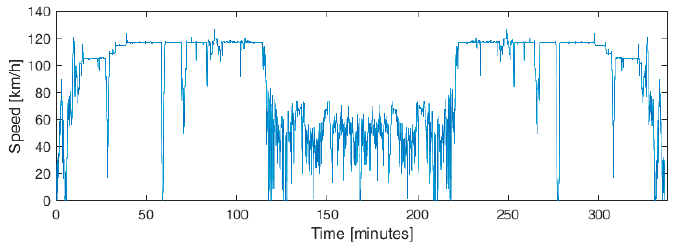
Figure 16. Highway + mountain mission altitude profile.